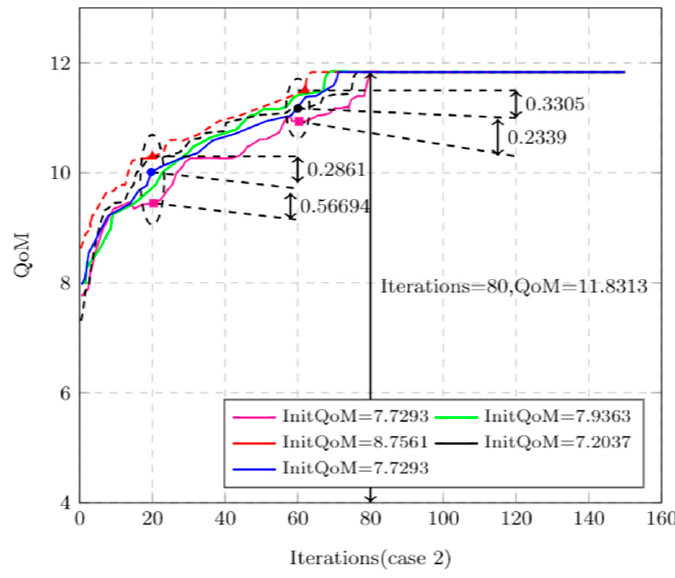
Figure 13. Convergence experiment in Case 2.